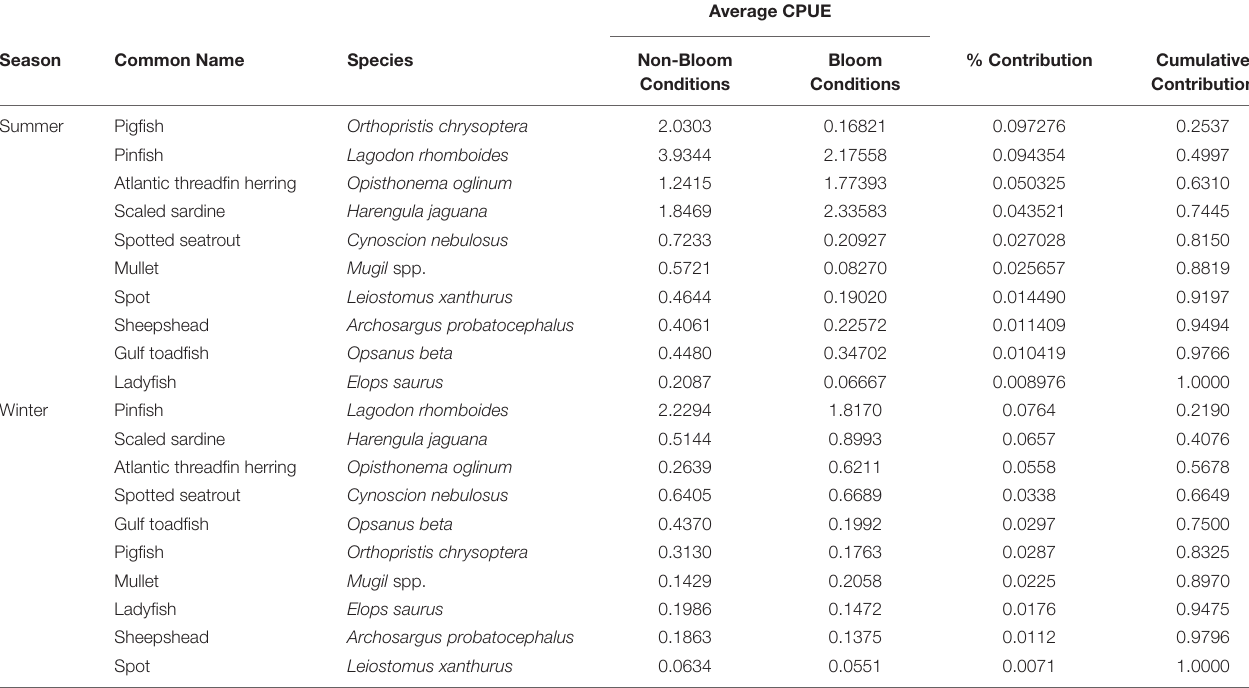
TABLE 5 | Summary of similarity of percentage (SIMPER) analyses comparing the difference in prey assemblage composition between non-bloom and bloom conditions during each season,